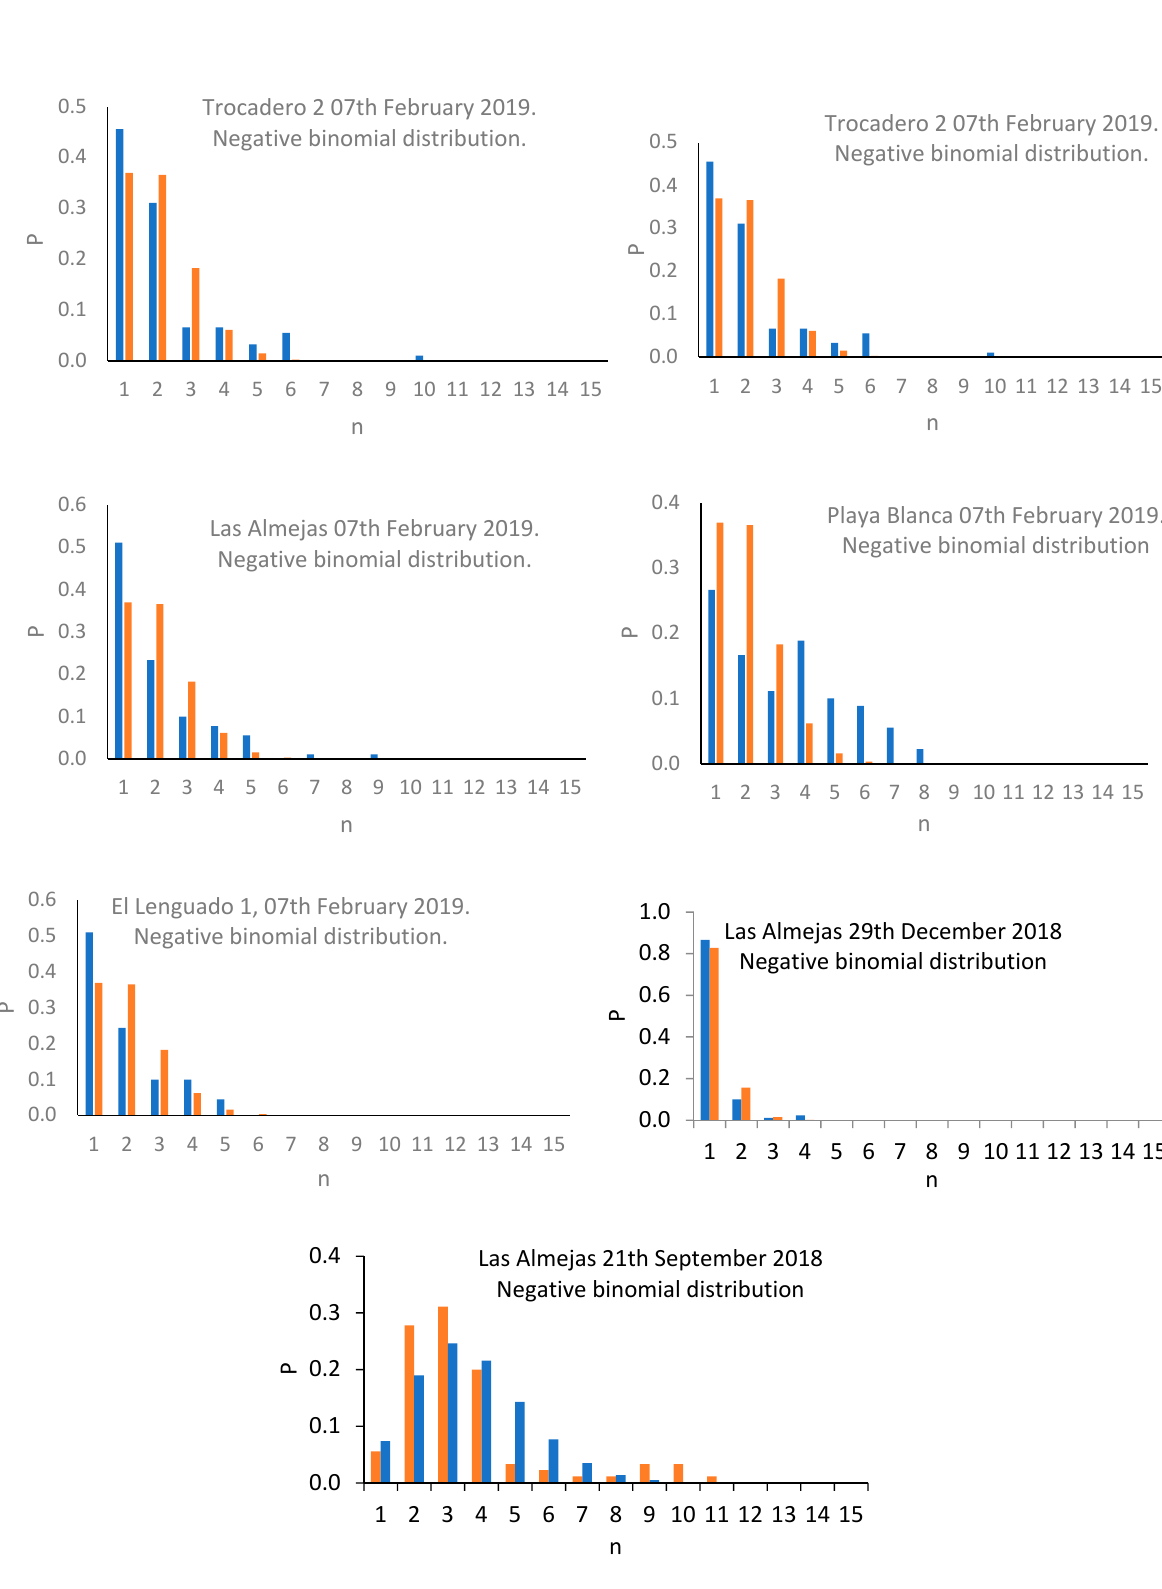
Figure 2. Distribution patterns observed for C. cinereus populations in sampling events.